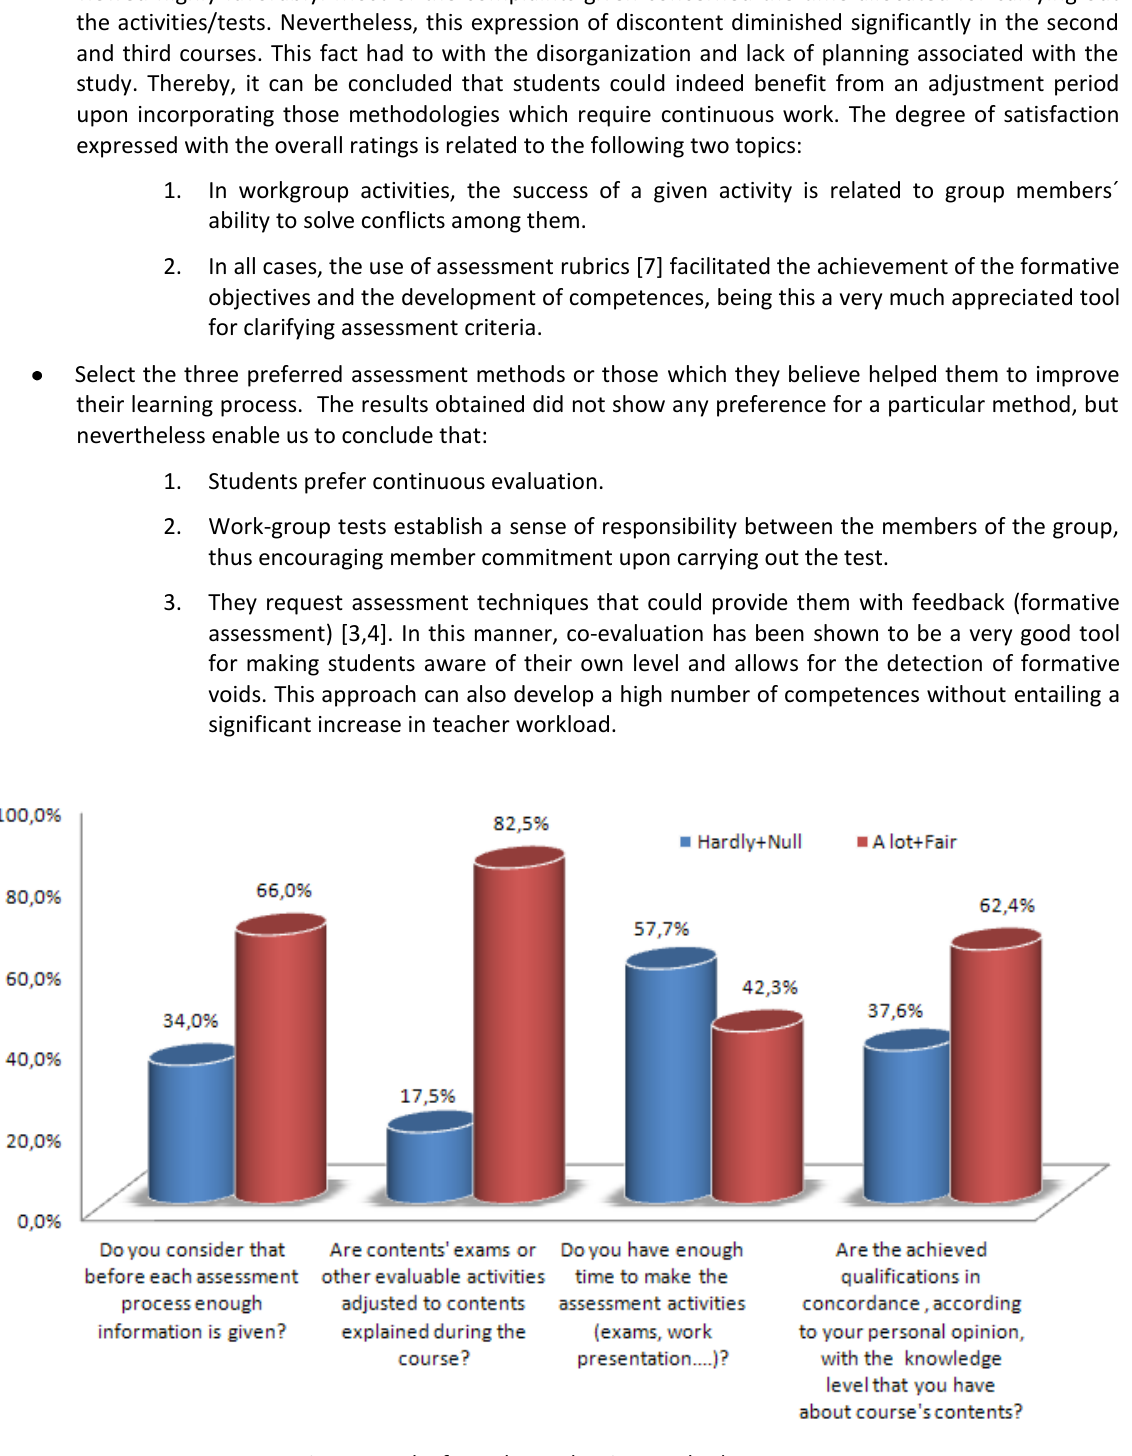
Fig. 6. Results from the evaluation methods